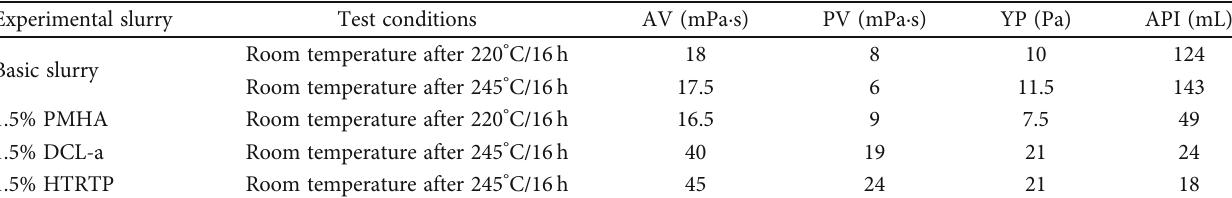
Table 7: Comparison of fl uid loss controlling of fl uid loss agents in saturated brine